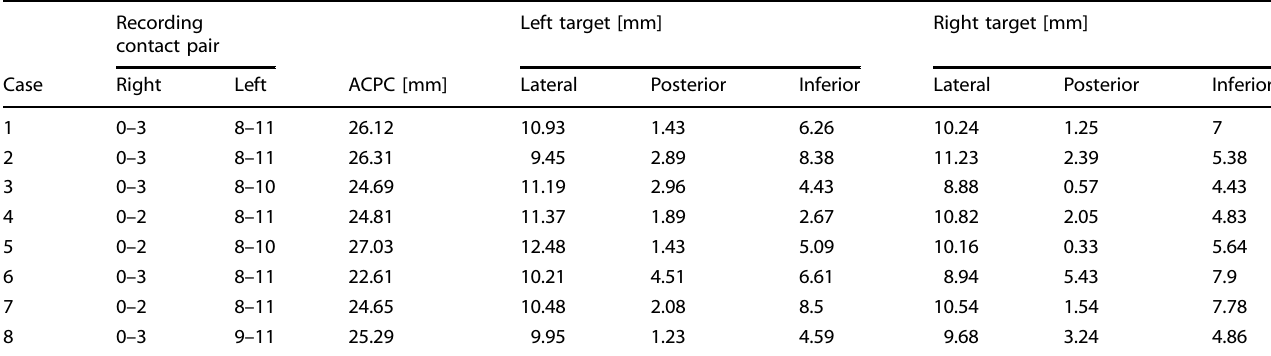
Table 2. Target coordinates of the contact